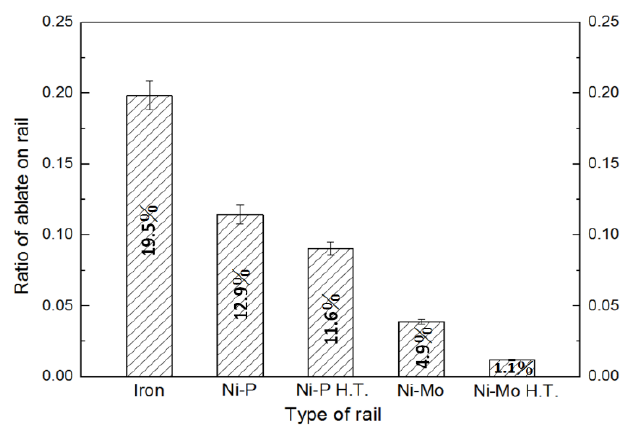
Figure 6. Ratio of ablated area to the rail area after catapult test.